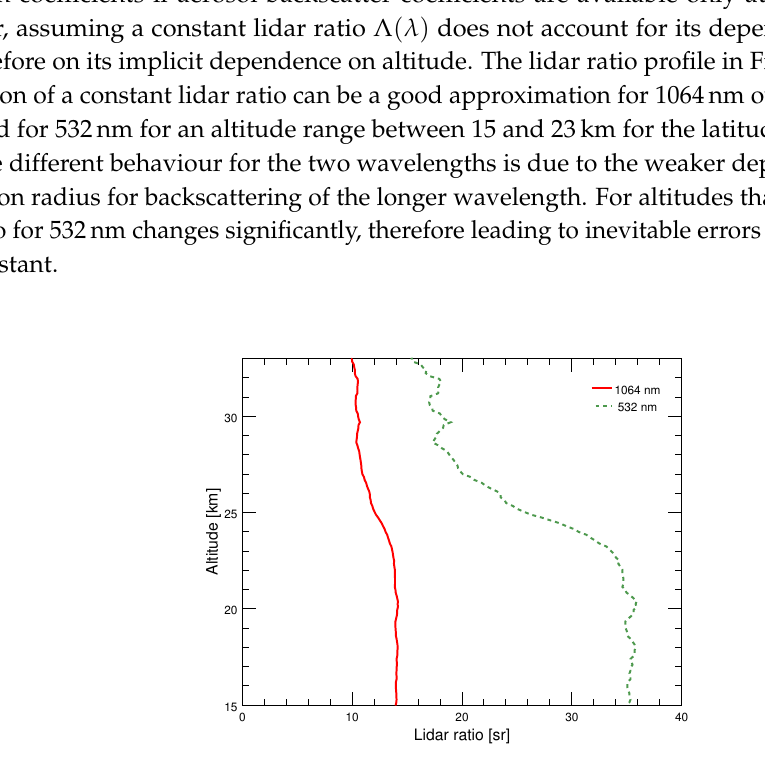
Figure 6. Stratospheric aerosol lidar ratio profile derived from measurements during March 2013 with an assumed distribution width of S =